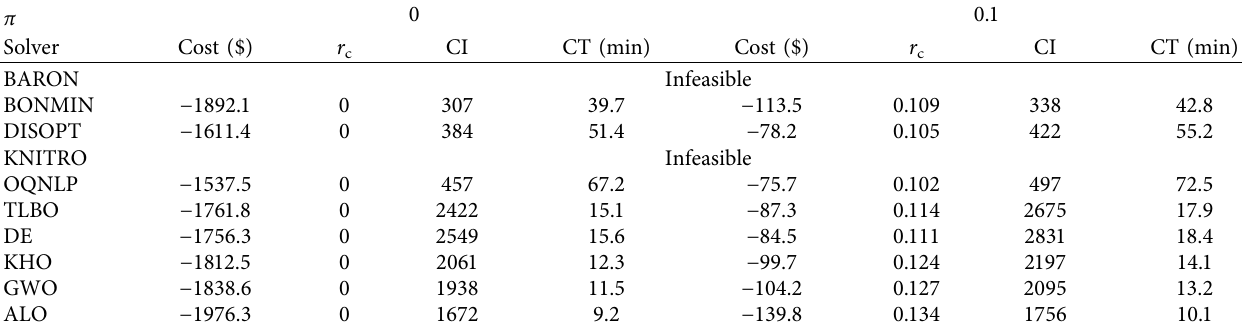
Table 3: Convergence situation achieved by diferent solvers for diferent values of robustness degree. π